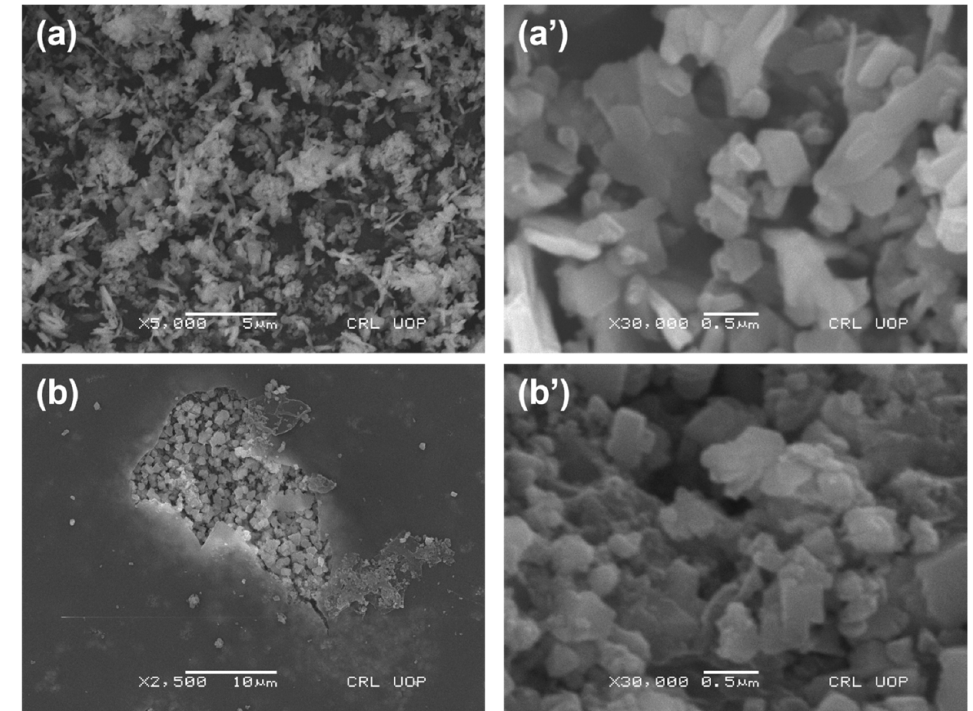
Figure 2. SEM images of ( a , a’ ) CuO-TiO 2 and ( b , b’ ) CMC/CuO-TiO 2 .